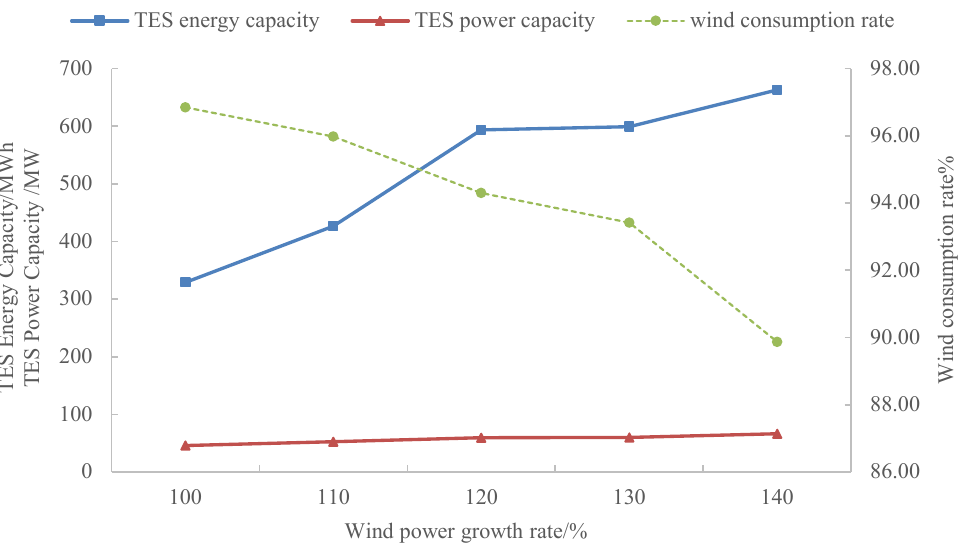
Figure 11. The impact of increased wind power capacity on TES configuration and wind power consumption.